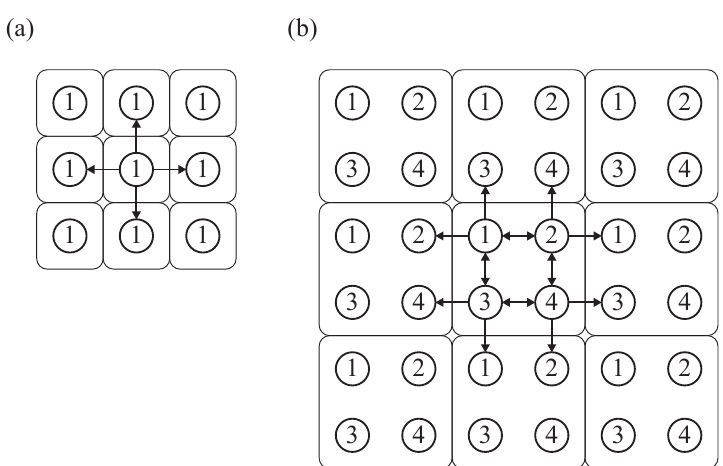
Figure 10: Lattice configuration for the Wannier90 input for (a) the paramagnetic state and (b) the AFM state. The circles show sites (atoms) and the number is the label of the site in the unit cell indicated by the square. The arrows indicate the hopping included in the input